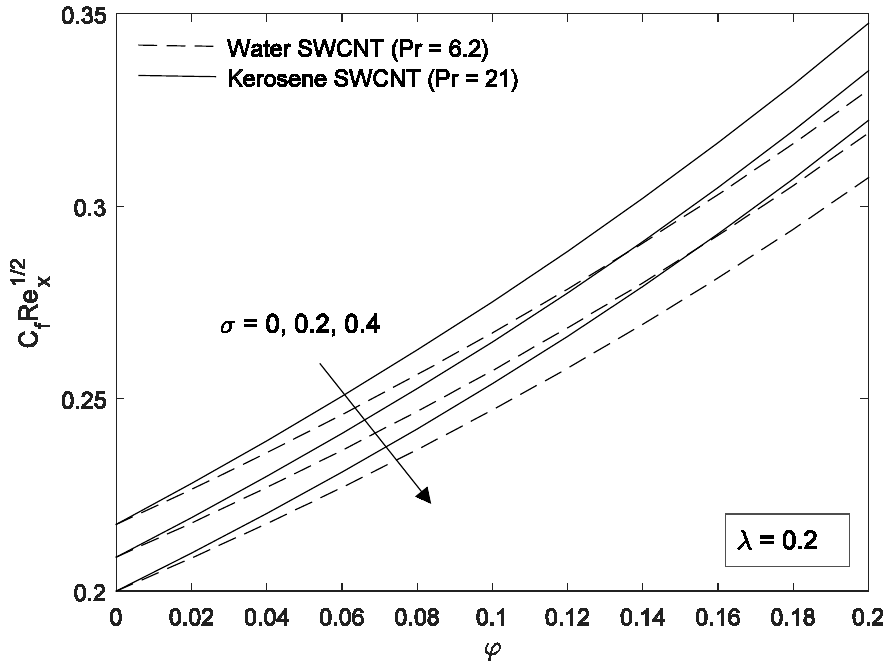
Figure 8. Effect of σ on skin friction for water-kerosene based fluid.